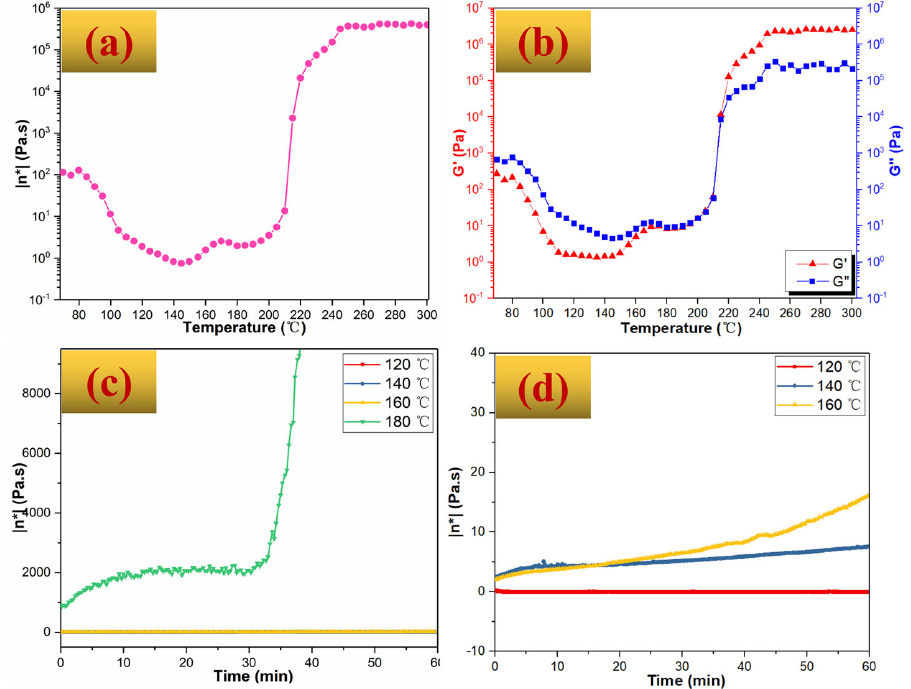
Figure 2. Rheological curves of BZPN/AC/TW foam precursor: ( a ) temperature scan of η *, ( b ) temperature scan of G ′ and G ″ , ( c ) time scan of η *, and ( d ) magnified time scan of η *.